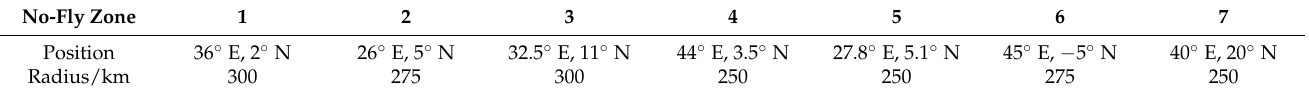
Table 2. The different positions and radii of multiple no-fly zones.